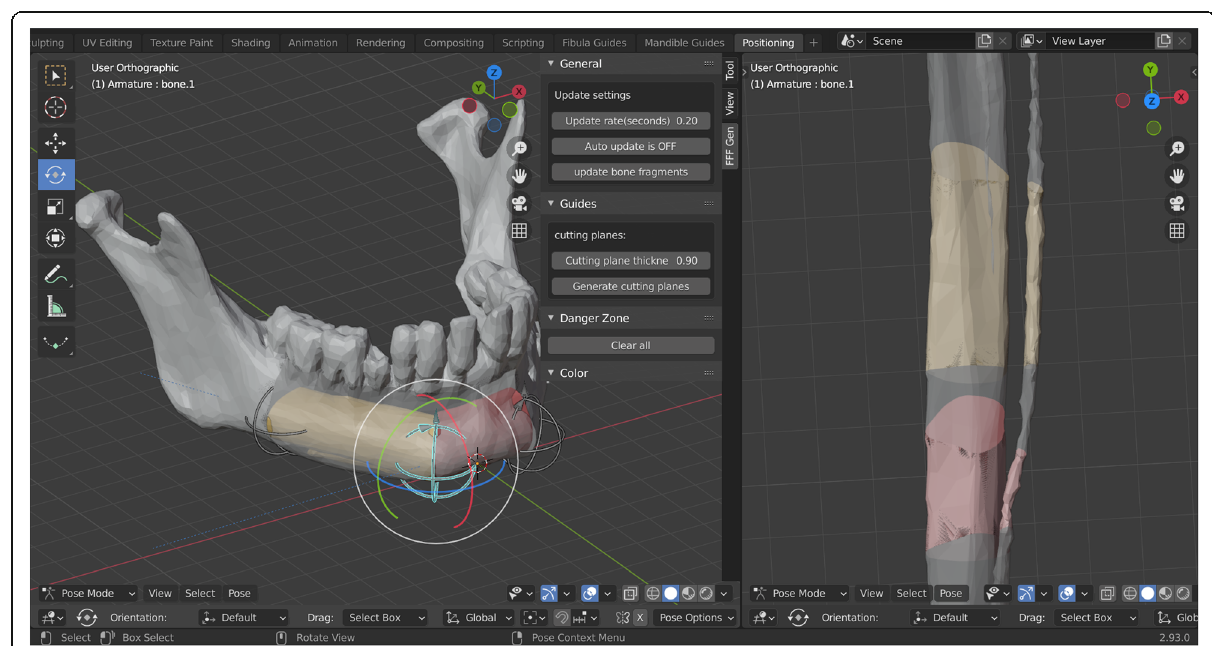
Fig. 2 User interface after initialising the add-on, loading mandible and fibula three-dimensional models, and initialising the rig. Fibula grafts are virtually positioned according to the native mandible